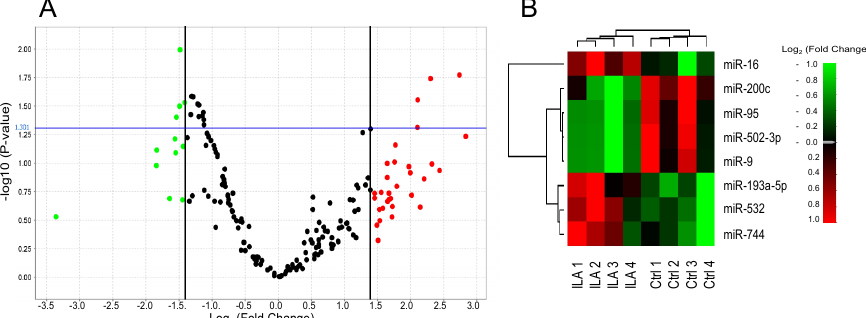
Figure 1. Identification of microRNAs differentially expressed in ILA subjects in the screening cohort. Volcano plot ( A ) and heat map ( B ) of differentially expressed miRNAs in four pools of six samples of ILA compared to four pools of six samples of Ctrl ( p < 0.05 and log 2 fold change > 1.4) using PCR Array. In the volcano plot, significant miRNAs are indicated in red (up-regulated) or green (down-regulated) above the cutoff p -value (blue line, p < 0.05). ILA: subjects with interstitial lung abnormalities. Ctrl: control group.